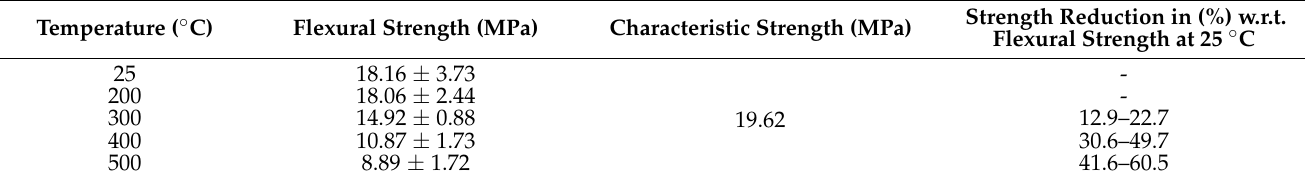
Table 1. Results of the thermal shock experiment for porous YSZ beams.